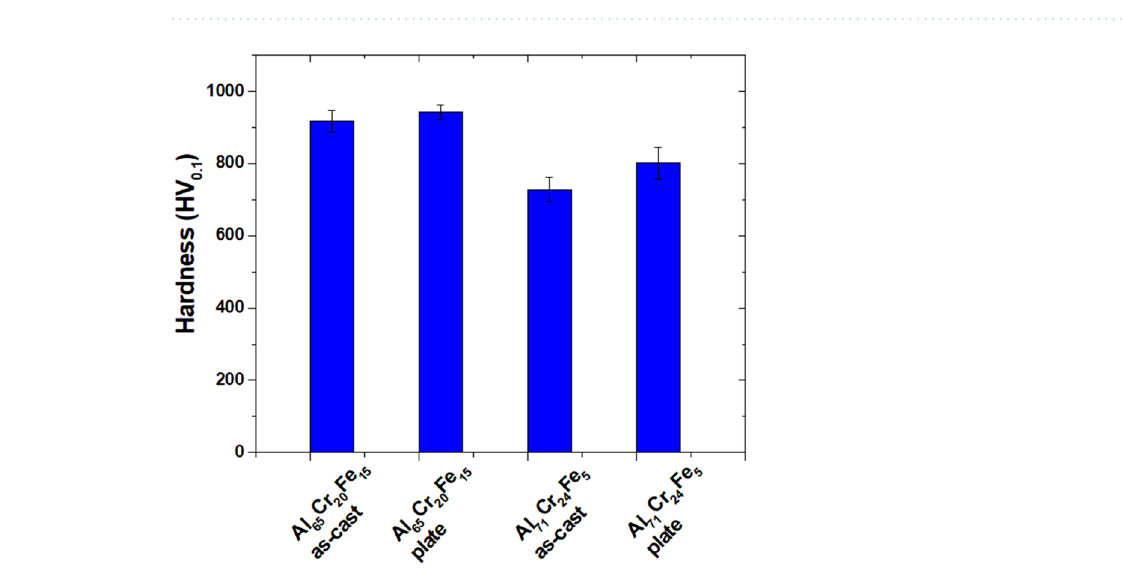
Figure 8. Comparison of hardness for Al 65 Cr 20 Fe 15 and Al 71 Cr 24 Fe 5 alloys in a form of ingots and